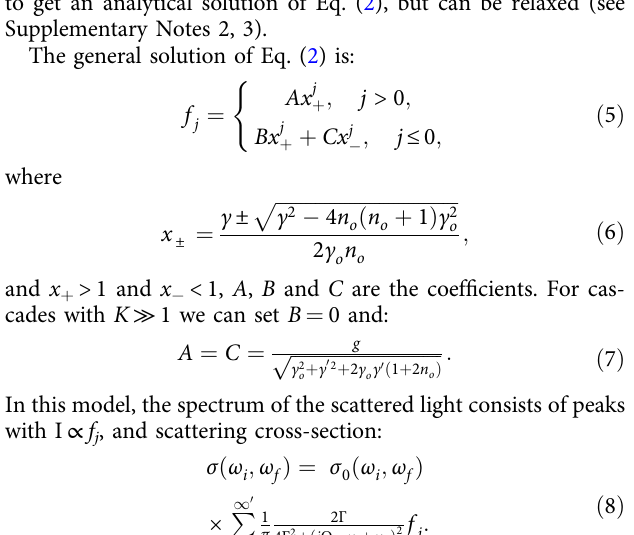
N ≥ 2 phonons are needed for the fi rst step of the cascade process, as for Fig. 3a. However, Fig. 1 shows that j = ±1 peaks are smaller than j = ±2 ones, but still detectable. We consider I S (1)/I S (2) as plotted in Fig. 3f. The possible mechanisms of j = 1 peak for- mation are as follows. (i) Elastic disorder or acoustic phonon- induced scattering, which provides a transfer between states within the light cone and states at the dispersion. (ii) Combina- tion of phonon emission and absorption, where the j = 1 peak appears as a result of two phonon emission, followed by one